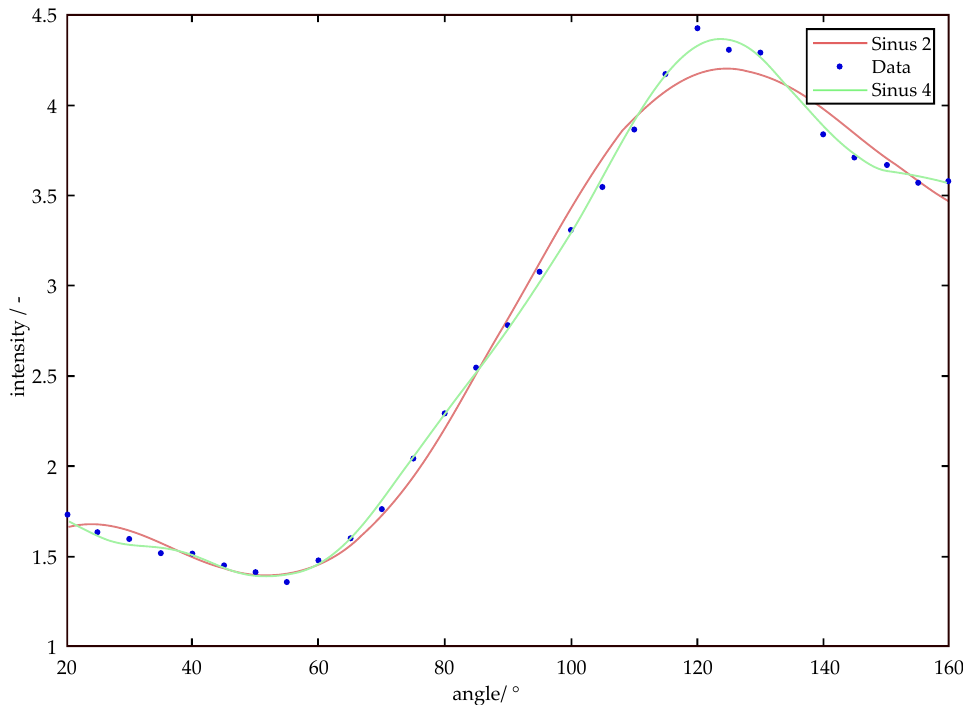
Figure 2. Approximation of measurement data by the sum of 2 and 4 sinusoidal